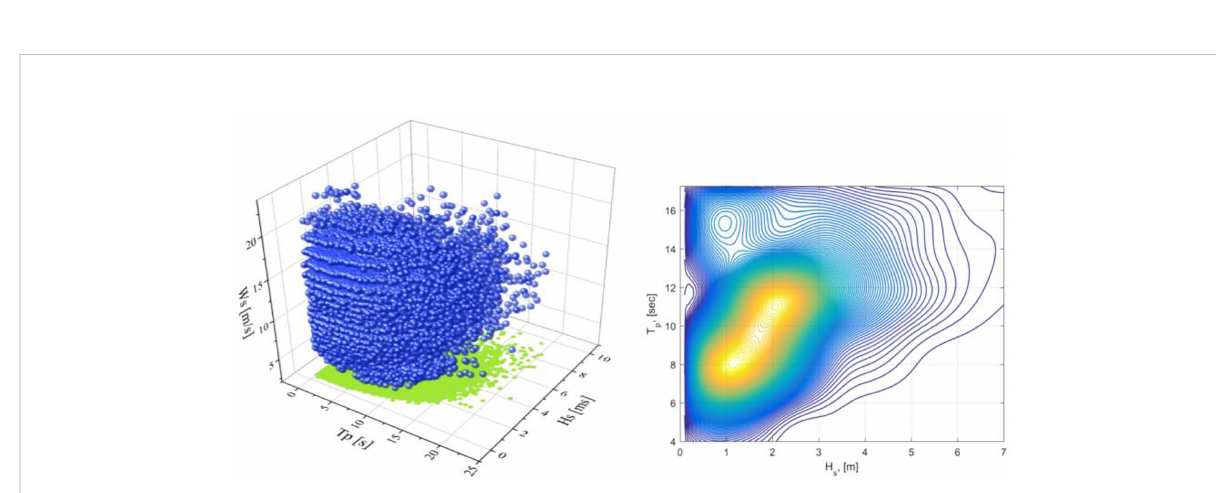
FIGURE 4 Left: 3D scatter of wind speed (Ws), signi fi cant wave height (Hs) and peak periods(Tp); Right:( H s , T p ) contour plot, p ( H s T p )= dU